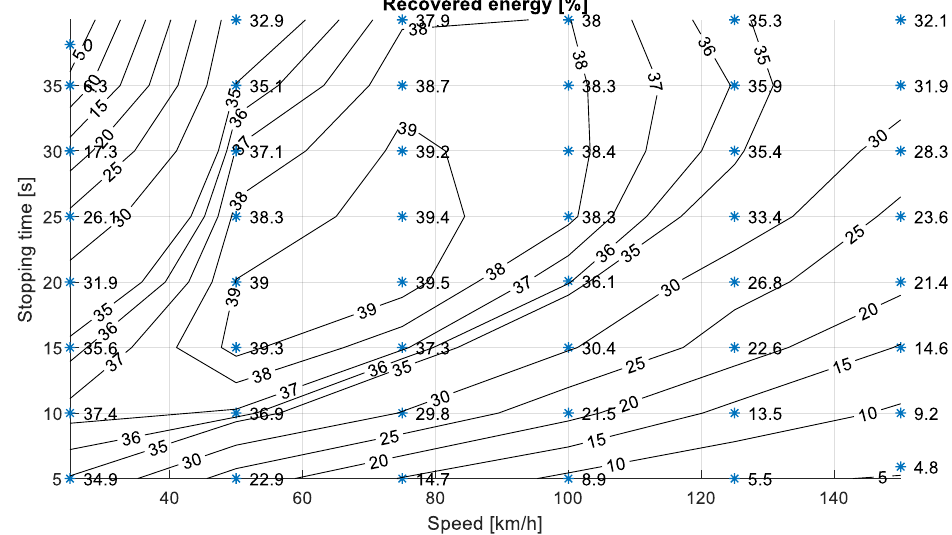
Figure 15. Braking distance versus stopping time, at various starting speeds. Black points indicate the conditions of best energy recovery.